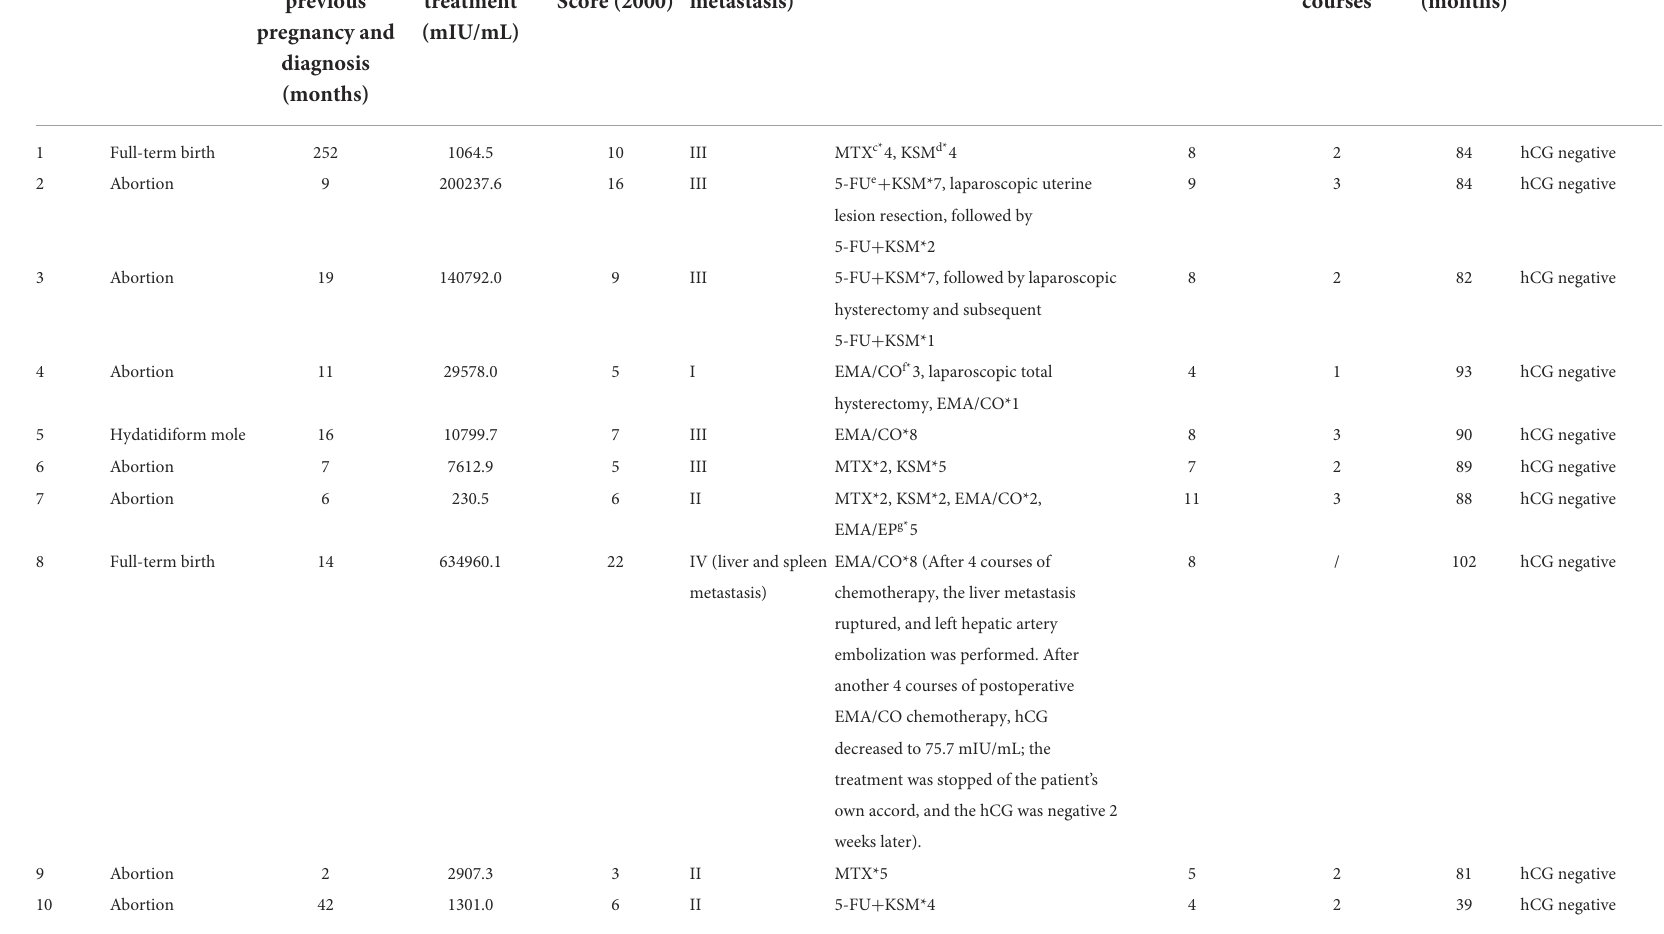
TABLE 2 The clinical characteristics, treatment, and prognosis of 14 patients diagnosed with GTN. Patient